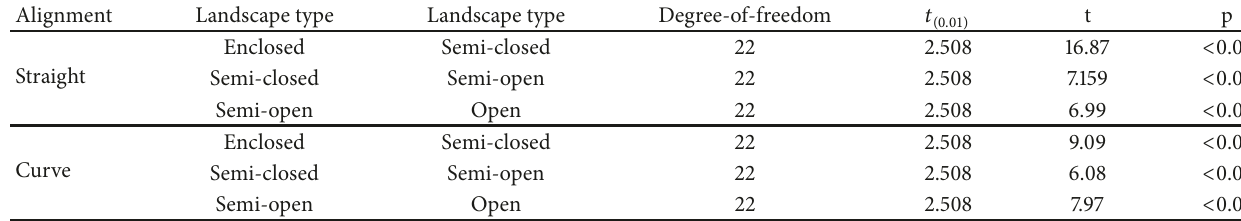
Table 4: T-tests to compare reaction times for adjacent